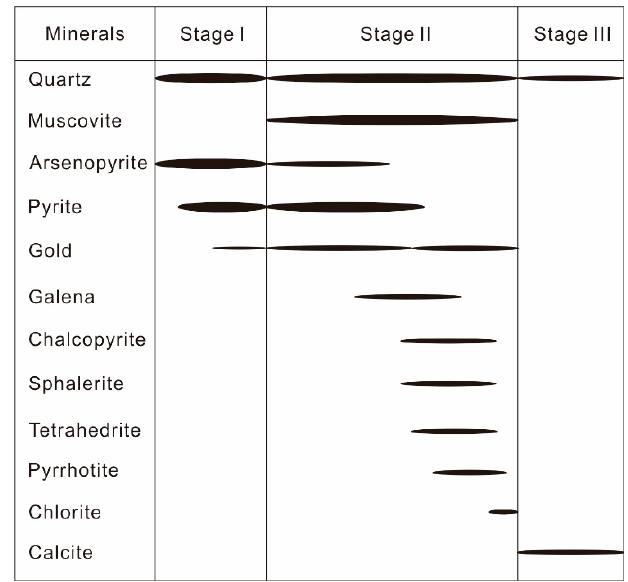
Figure 4. Paragenetic assemblages and sequences of minerals at the Zhengchong gold deposit.